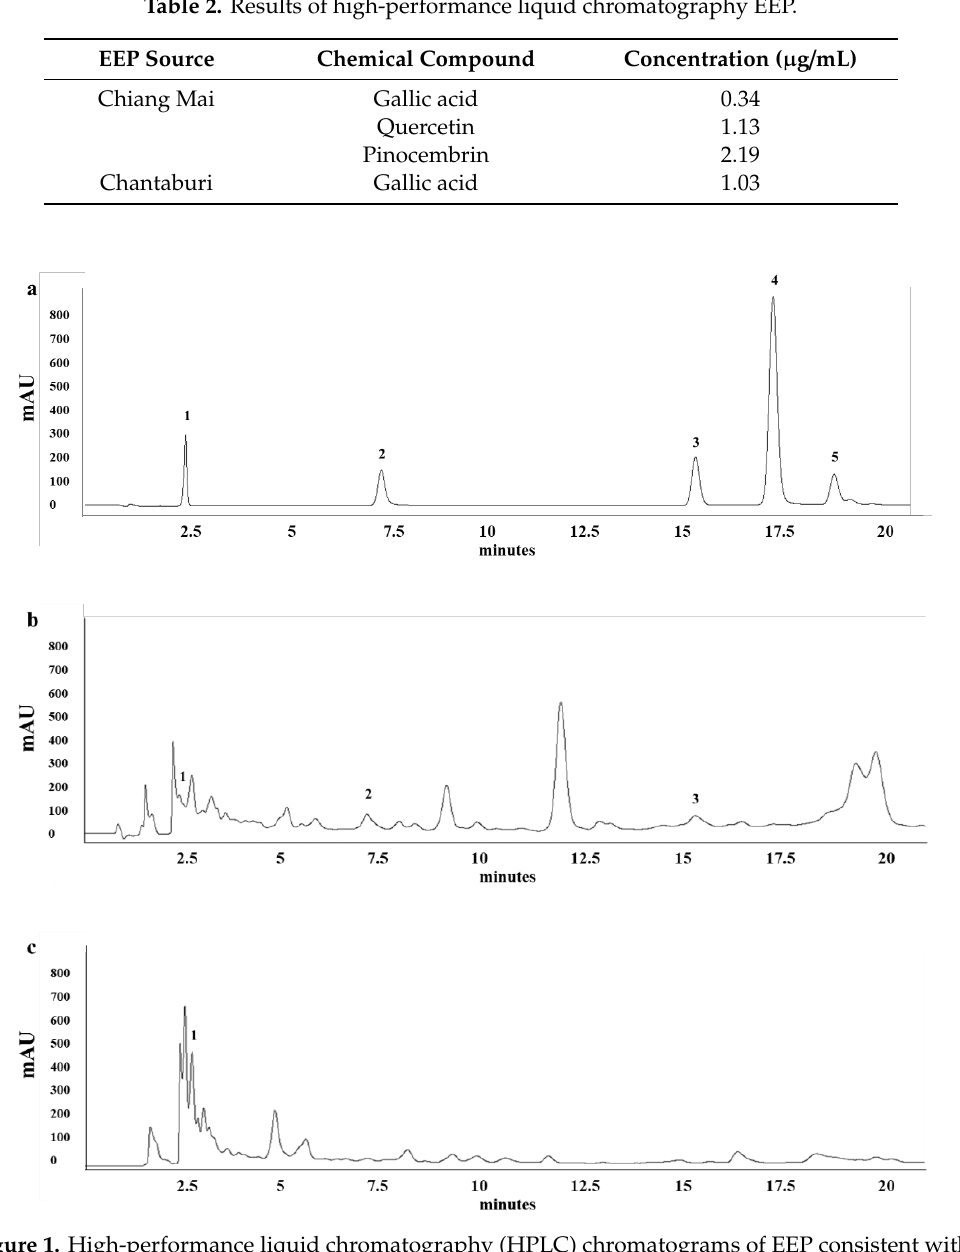
Figure 1. High-performance liquid chromatography (HPLC) chromatograms of EEP consistent with the quantitation and identification. ( a ) The standard composition: (1) gallic acid, (2) quercetin, (3) pinocembrin, (4) chrysin, and (5) galangin. ( b ) EEP of Chiang Mai. ( c ) EEP of